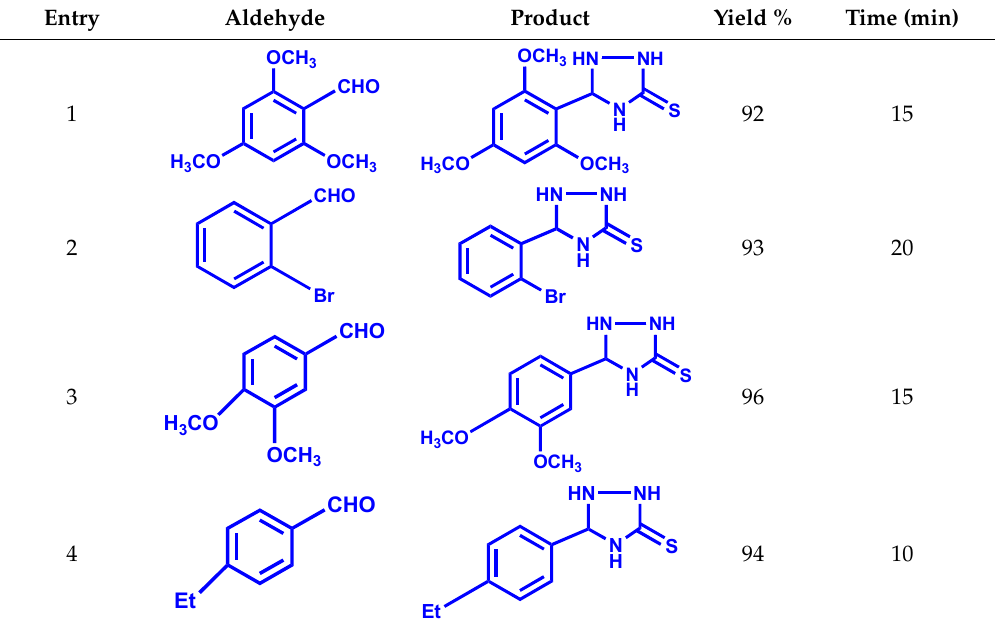
Table 3. List of synthesis of 1,2,4-triazolidine-3-thione moiety with different substituted aromatic aldehydes with Sm-FAp/Glycine as heterogeneous catalyst *.